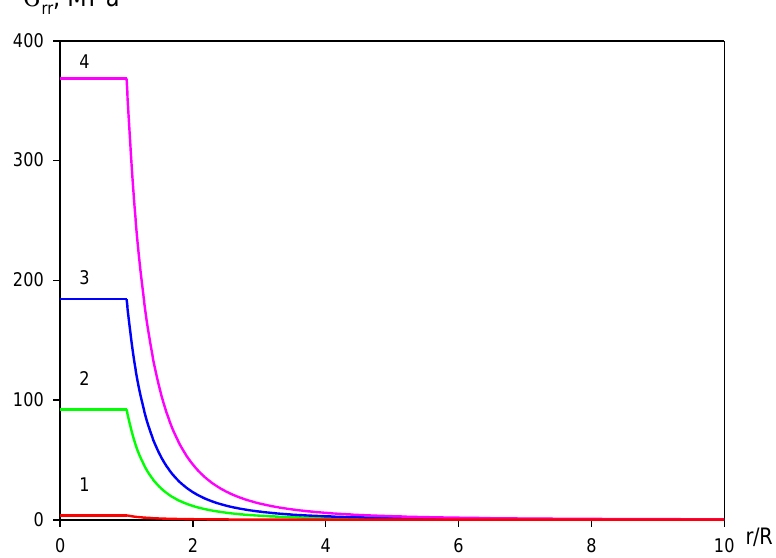
Figure 6. The distribution of the radial stresses σ rr in the particle ScF 3 and matrix for various values of the temperature difference: 1 —Δ T = 10 K; 2 — 50 K; 3 — 100 K; 4 — 200 K.